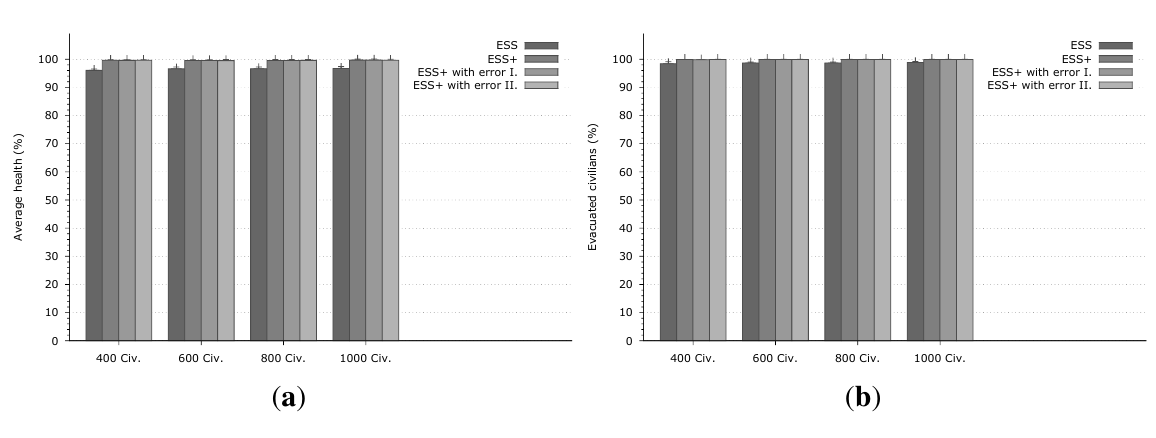
Figure 5. Results of the evacuation when the fire was generated at node 100 − 2 . ( a ) Average evacuee health vs. number of civilians; ( b ) Evacuated civilians vs. number of